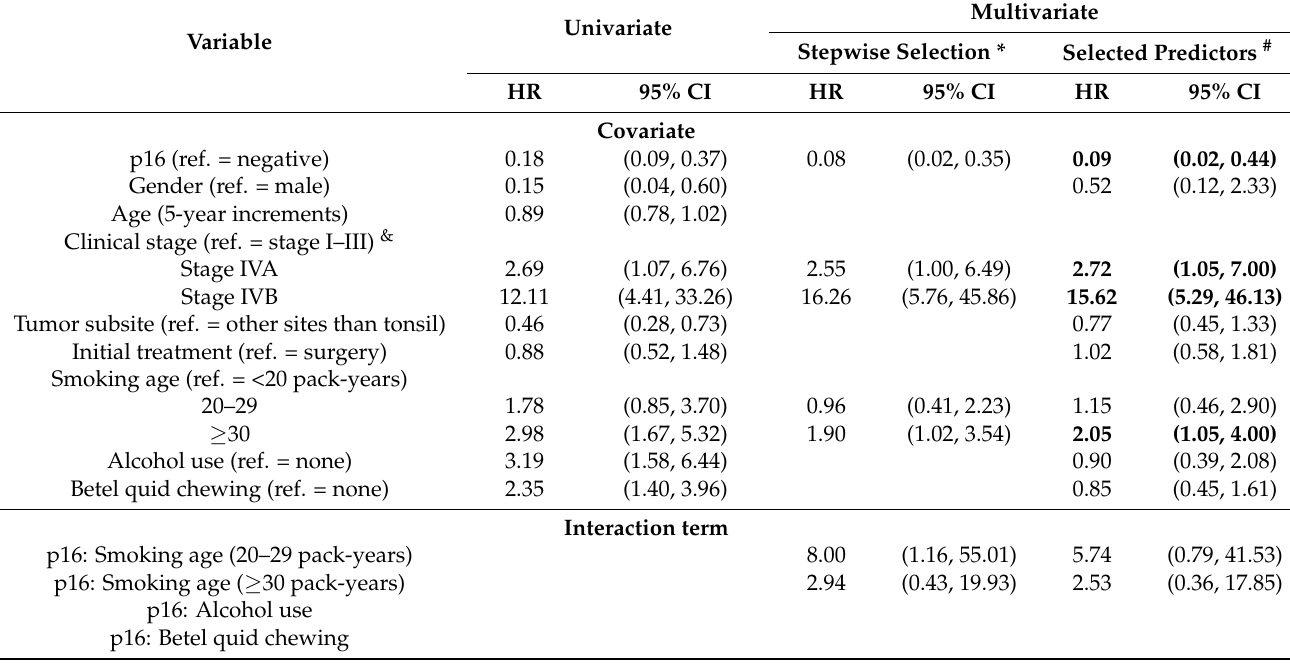
Table 2. Univariate and multivariate analyses for overall survival.